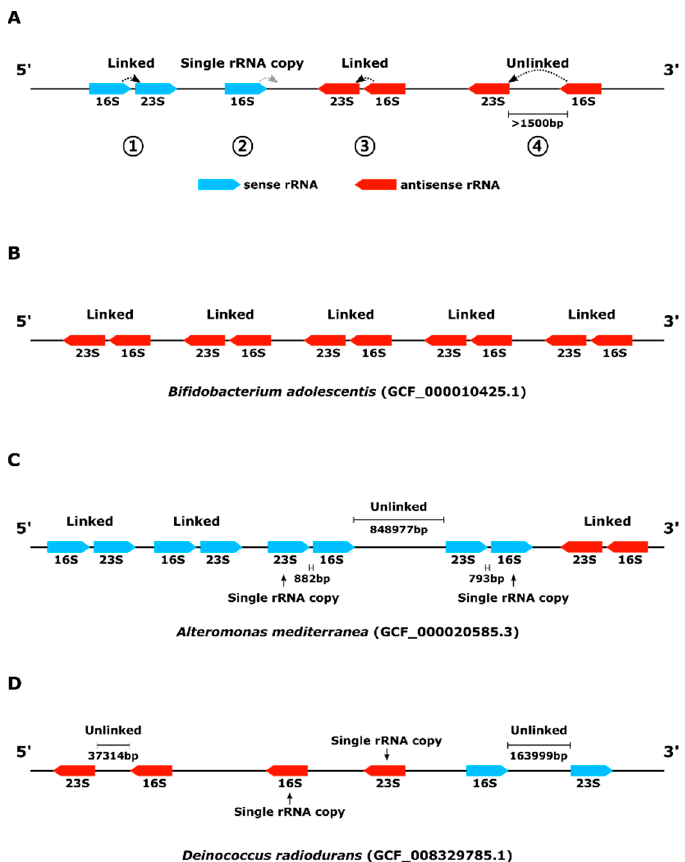
Figure 2. Schematic diagram of rRNA operon identification in the genome sequence. ( A ) rRNA operon diagram; ( B ) rRNA operon-linked genome; ( C ) rRNA operon-mixed genome; ( D ) rRNA operon-unlinked genome.